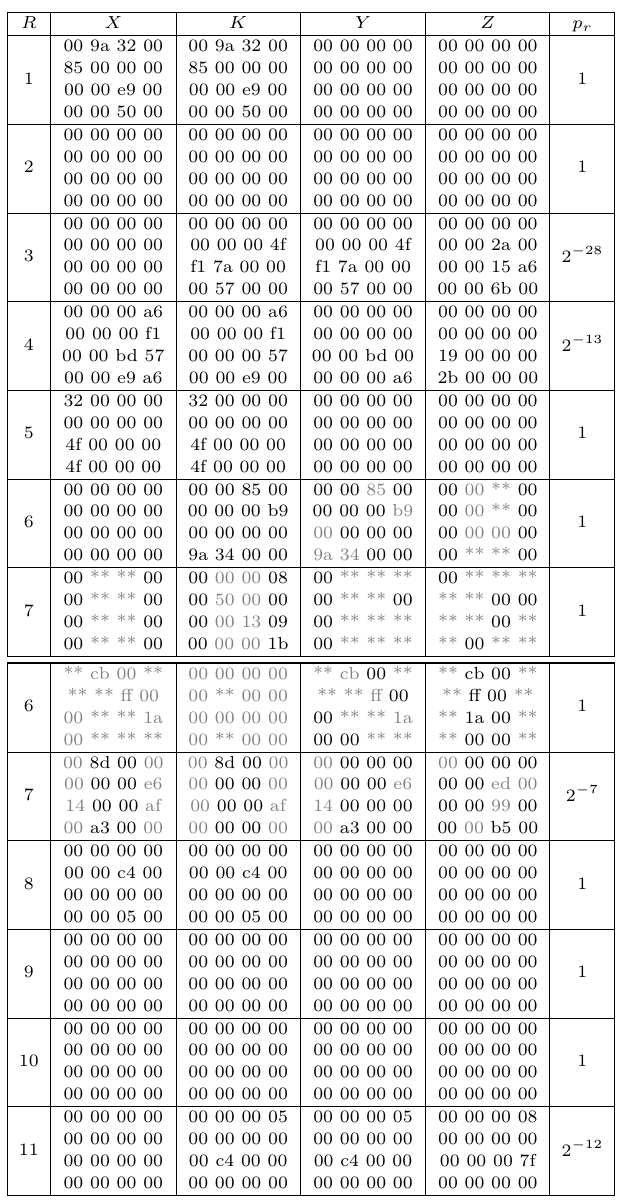
Table 12: 11-round distinguisher of